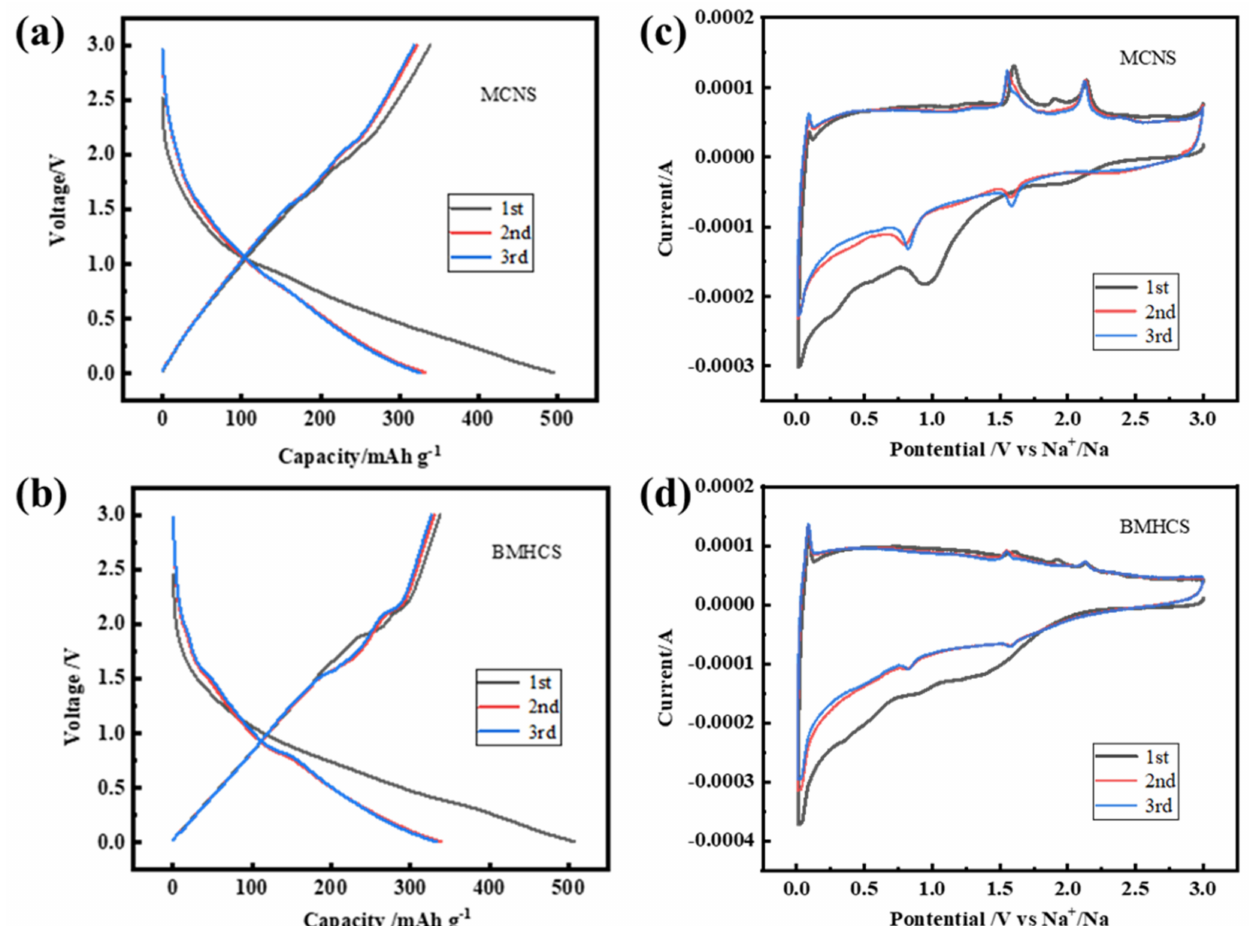
Figure 8. ( a , b ) First three charge–discharge curves at 1 A g − 1 ; ( c , d ) CV curves at 0.2 mV s − 1 of the initial three cycles of MCNS and BMHCS.